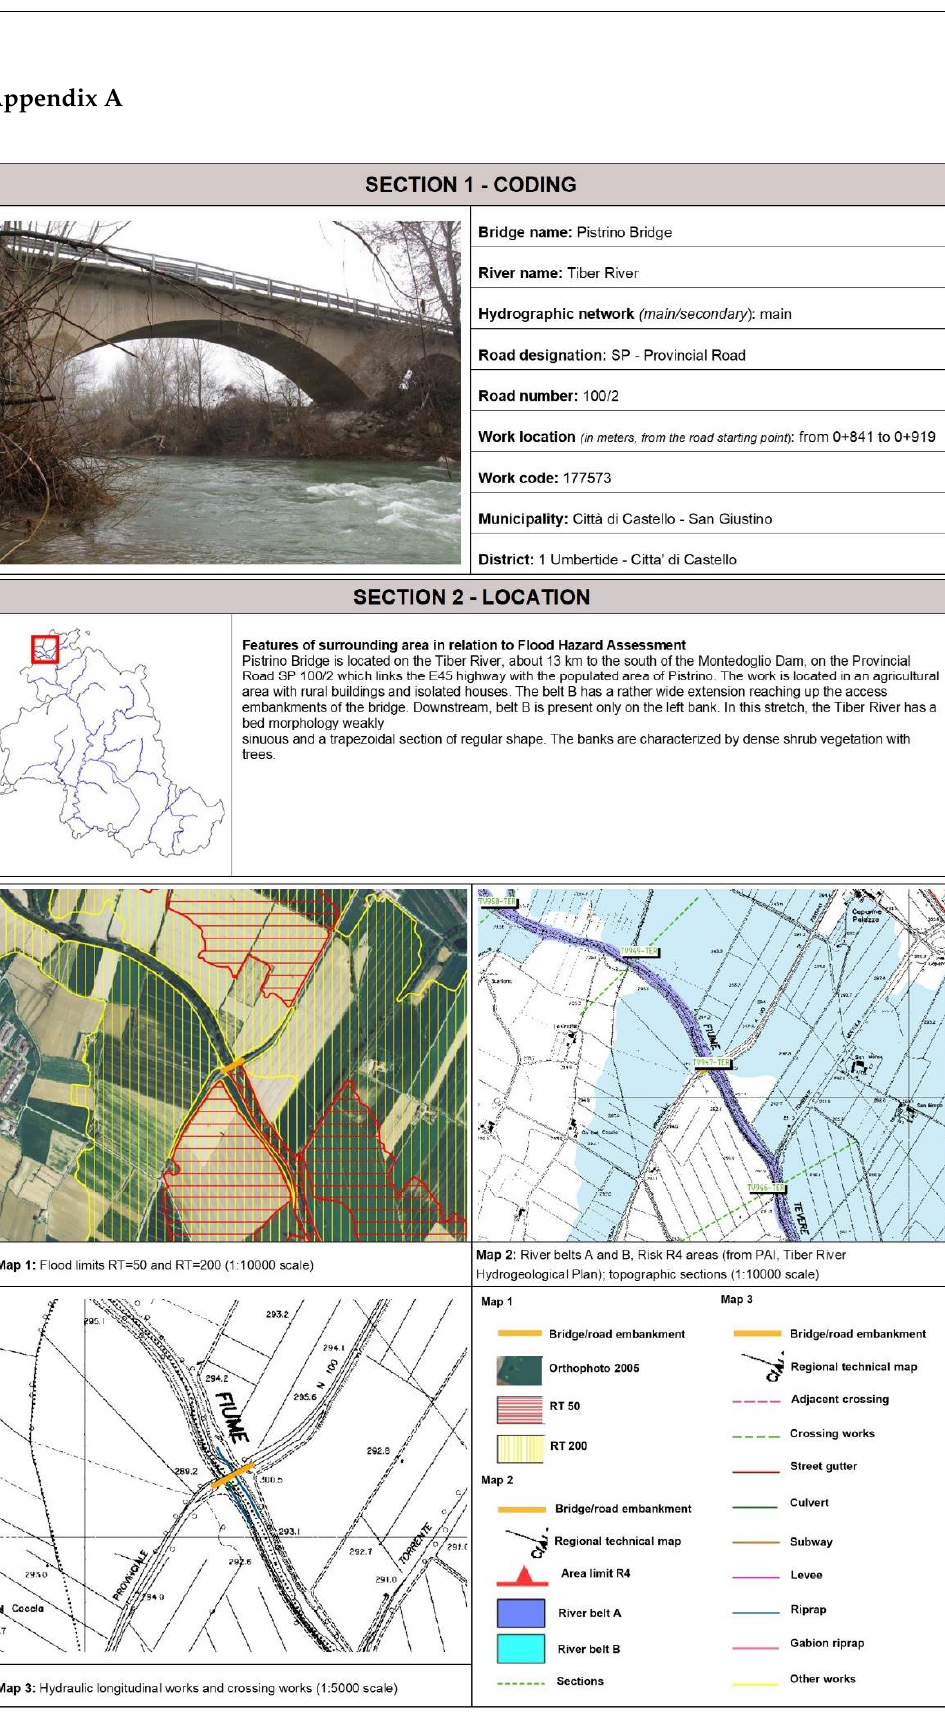
Figure A1. Synoptic table for Sections 1 and 2.